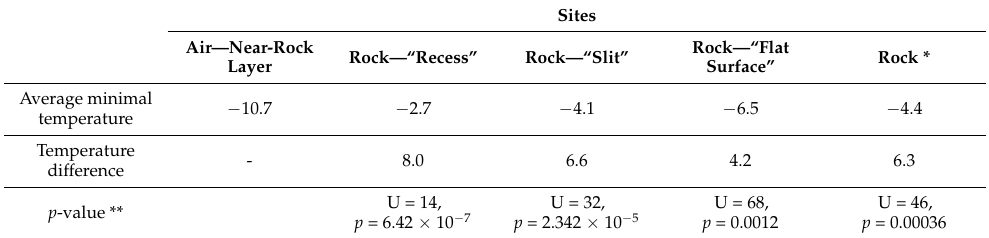
values of air temperature and the temperature differences (between the “slit” and the air) * Rock—average values for three rock microhabitats. ** p -value—the results of the analysis according to the criterion U (Mann–Whitney).